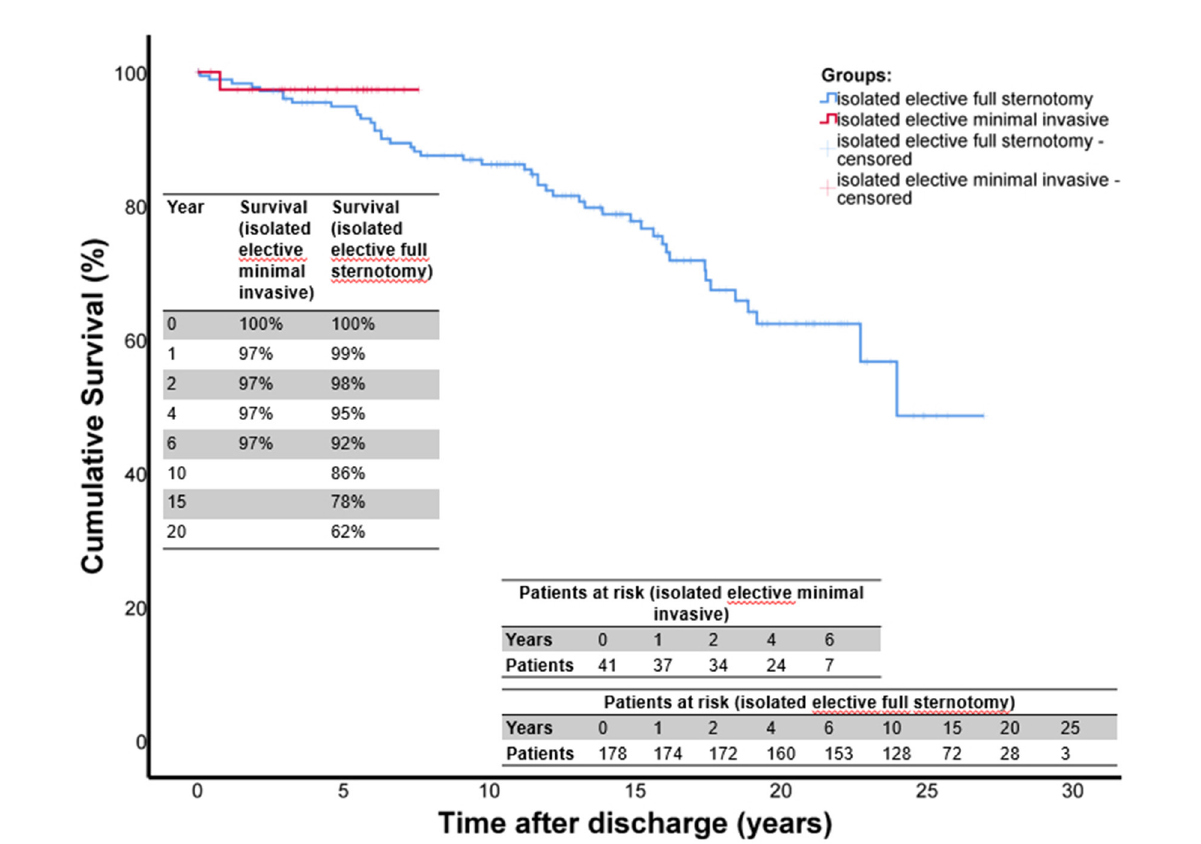
FIGURE1 Survival after isolated elective AVSRR. This figure shows the Kaplan Meier survival curves for patients who underwent isolated, elective David-I procedure. The red curve shows the mini access patients (group A) and the blue curve shows the full sternotomy patients (group B). Time origin on x-axis denotes day of